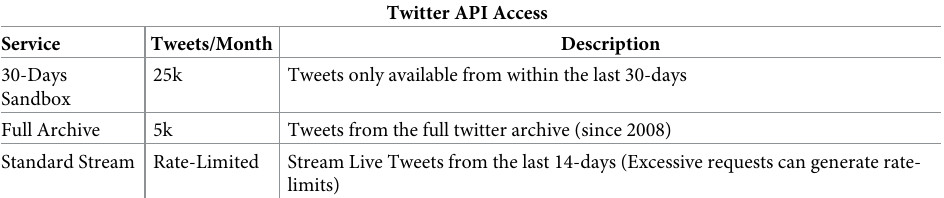
Table 2. Twitter API services &